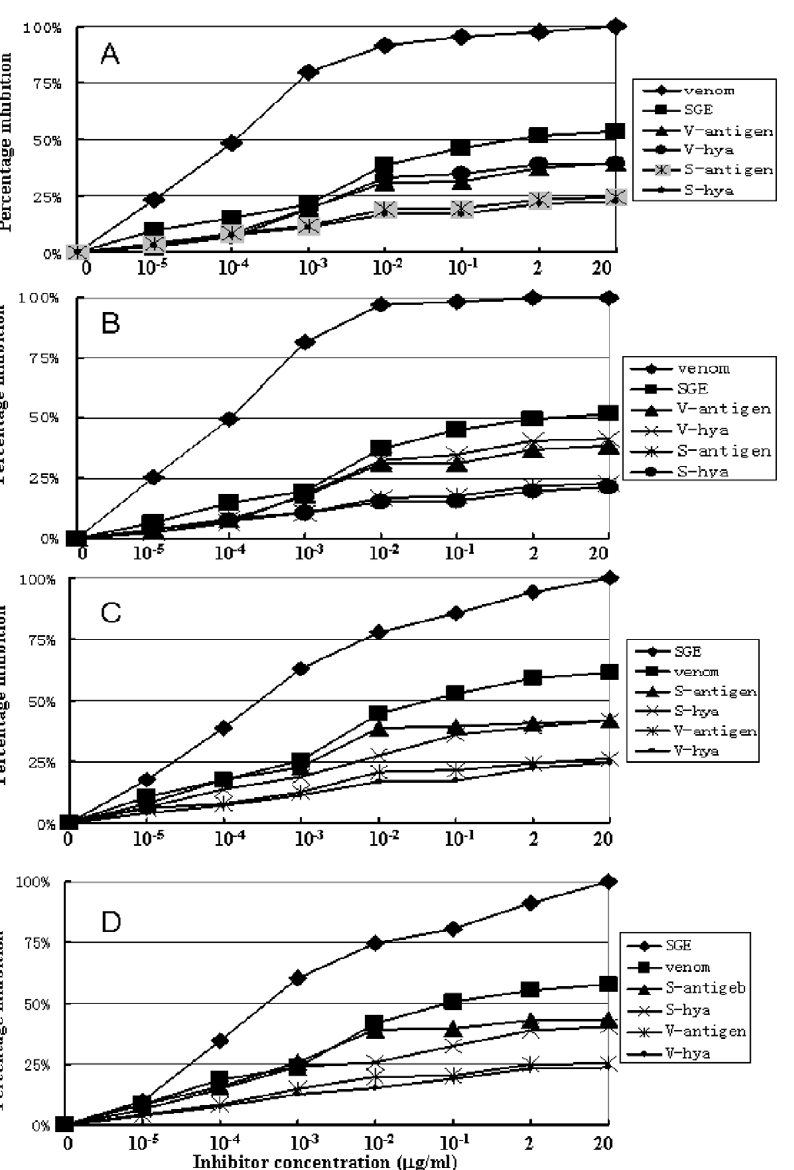
Figure 4. Cross ELISA inhibition of purified wasp and horsefly allergens with patients’ serum from subject 2, 3 and 8. A& B : 20 m g/ml coated wasp venom’s binding with serum IgE from subject 2 (A) and 8 (B) was inhibited by wasp venom, horsefly SGE, Vesp ma 5, Vesp ma 2, Tab y 5, and Tab y 2, respectively. C& D : 20 m g/ml coated horsefly SGE’s binding with serum IgE from subject 3 (C) and 8 (D) was inhibited by wasp venom, horsefly SGE, Vesp ma 5, Vesp ma 2, Tab y 5, and Tab y 2, respectively. Inhibitor concentrations ranged from 10 2 5 m g to 20 m g/ml. SGE: salivary gland extracts; V-antigen: Vesp ma 5; V-hya: Vesp ma 2; S-antigen: Tab y 5; S-hya: Tab y 2.